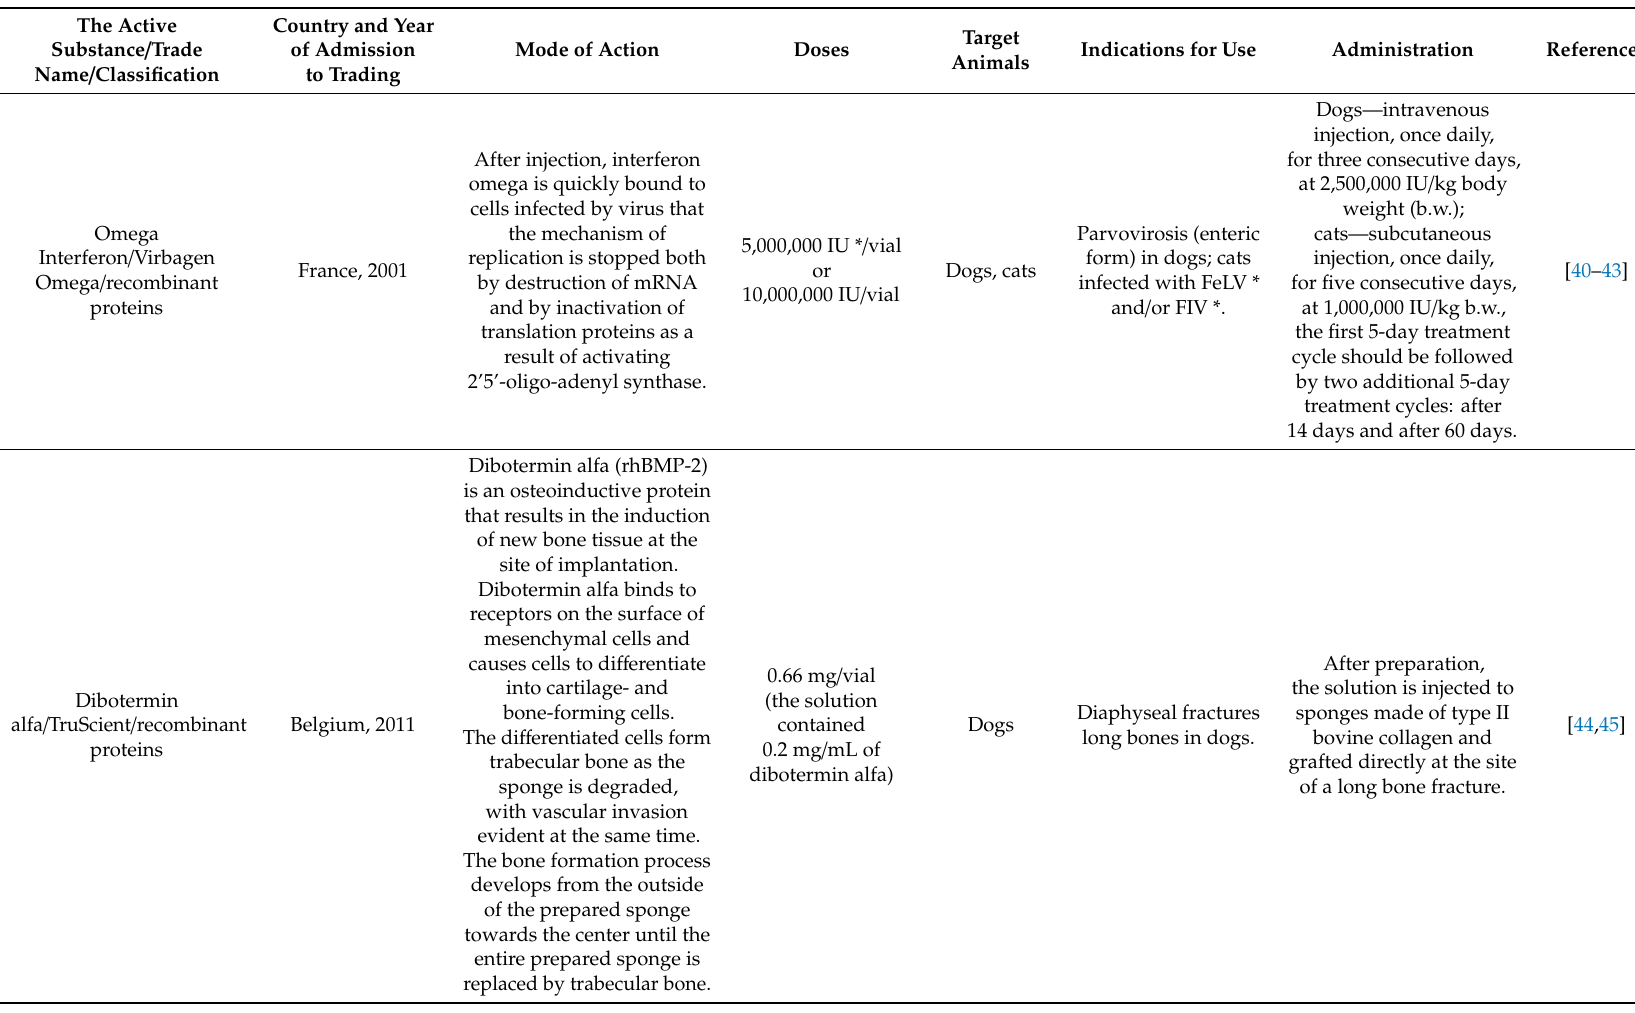
Table 1. Veterinary biological medicinal products approved for marketing by the European Medicines Agency